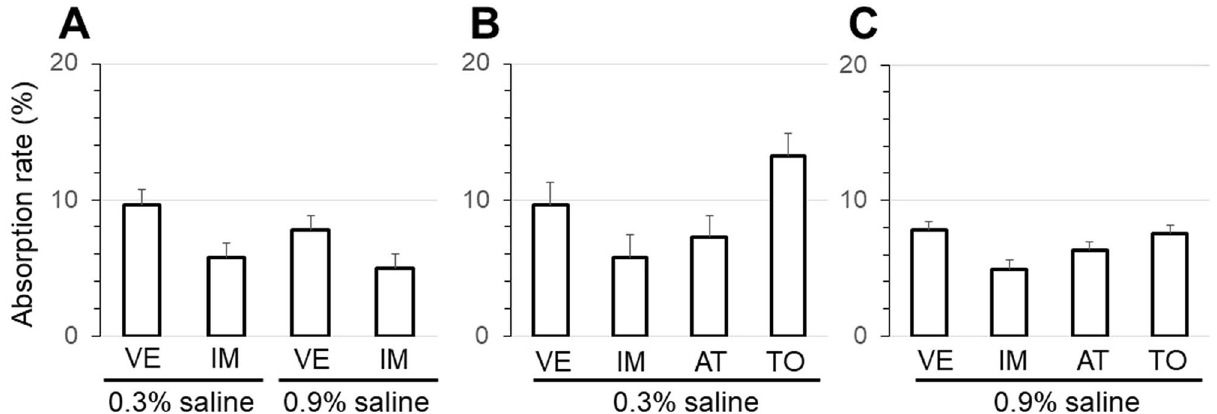
Figure 3. The absorption rate of the rat bladder wall was compared by administering three different anticholinergics. ( A ) Comparison between intravenous vehicle (VE) and imidafenacin (IM) (0.1 mg/kg) administration when the bladder was filled with 0.3% or 0.9% saline. Comparison among intravenous VE, IM (0.1 mg/kg), atropine (AT) (0.1 mg/kg), and tolterodine (TO) (0.3 mg/kg) administration when the bladder was filled with 0.9% saline ( C ). Values are the mean ± SEM of measurements in 8